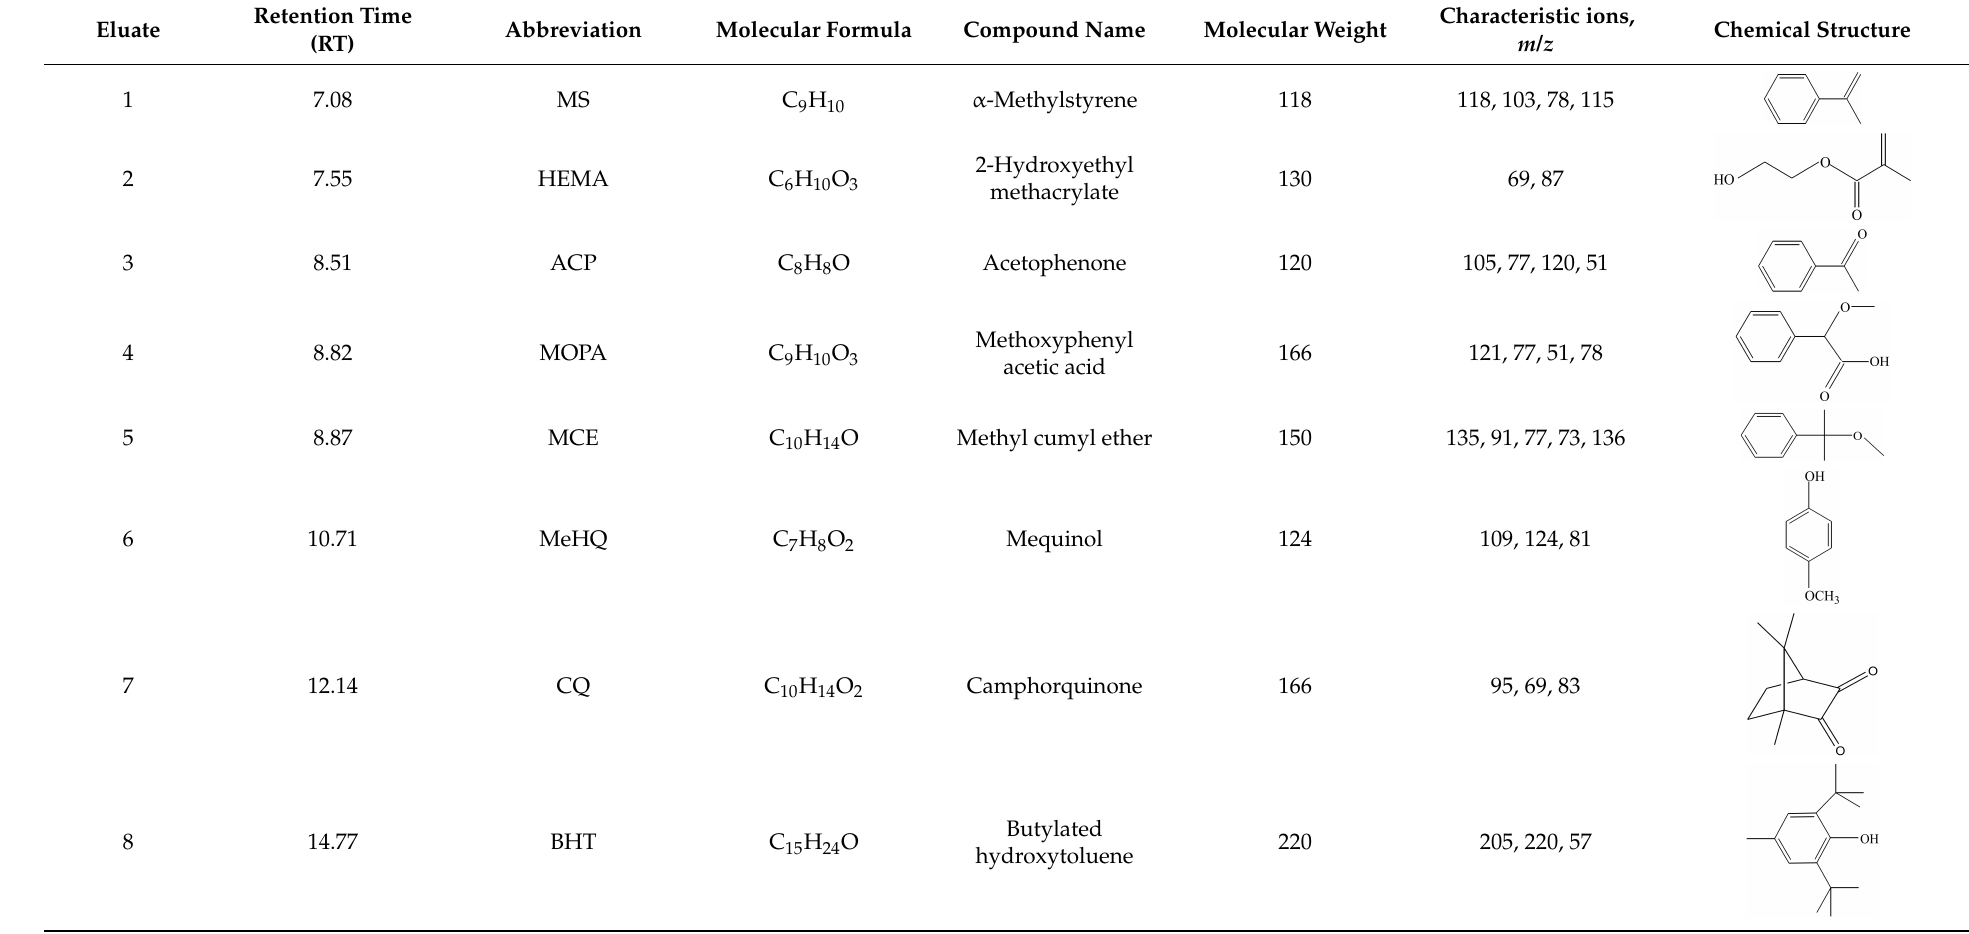
Table 1. Eluted substances arranged by increasing retention time, with abbreviation, molecular formula, compound name, molecular weight, characteristic ions and chemical structure.